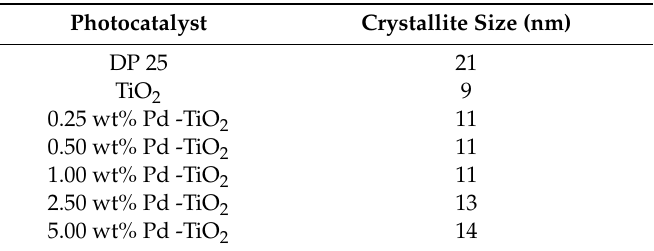
Table 3. Photocatalyst Crystallite